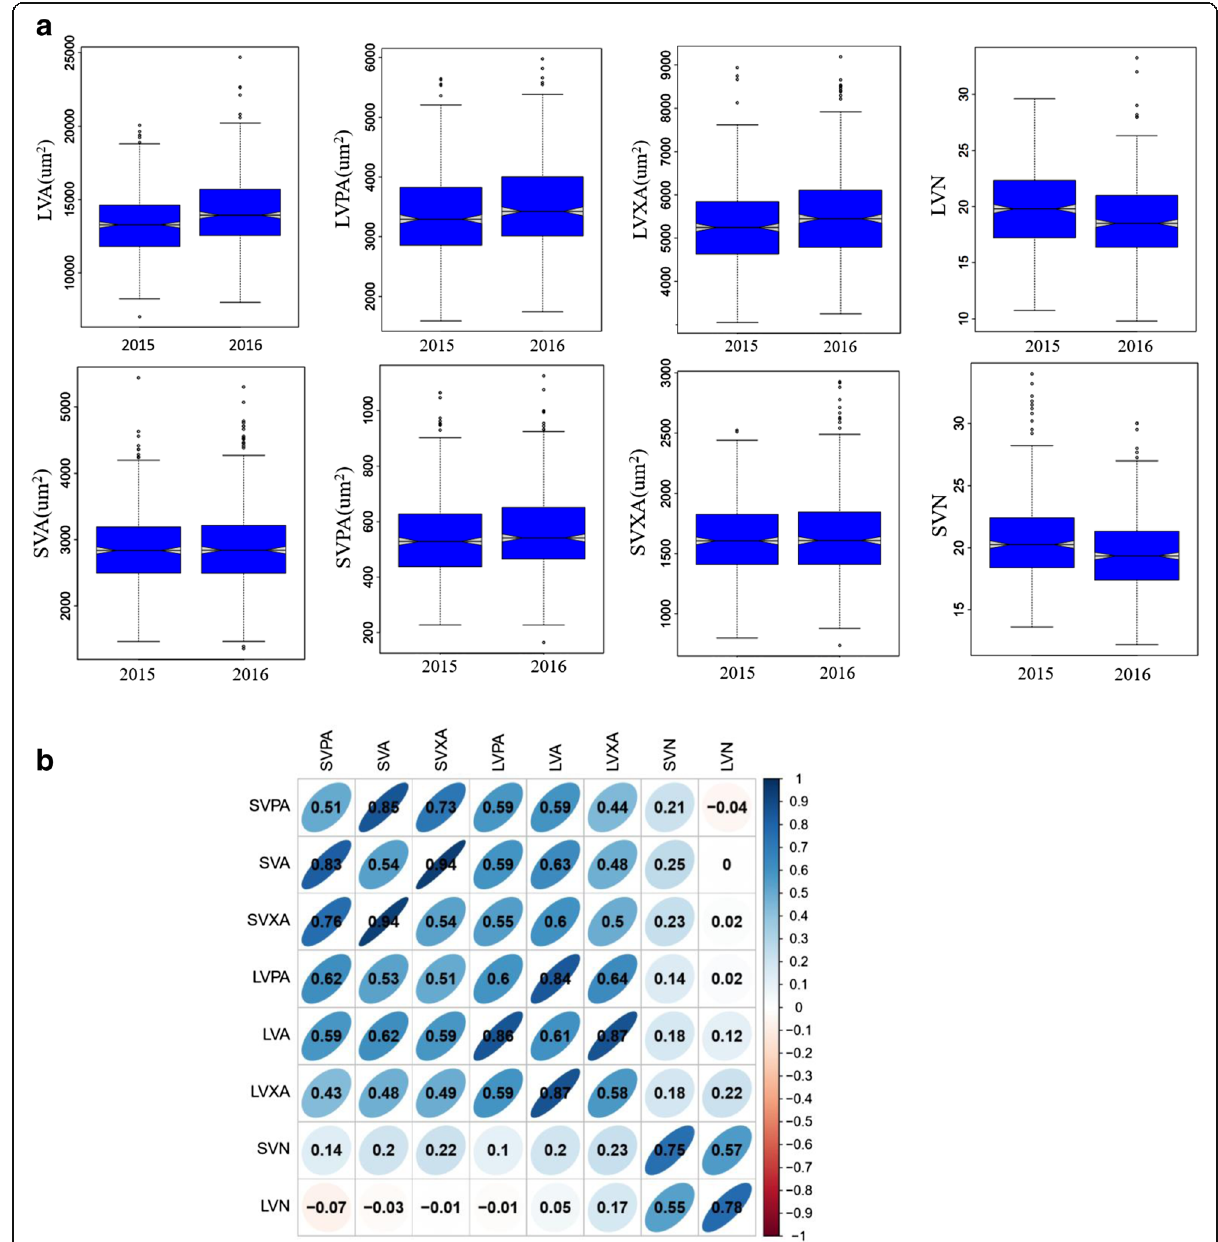
Fig. 1 a Box plots of eight rice vascular bundle related traits; the number of large vascular bundle (LVN), the area of large vascular bundle (LVA), the xylem area of large vascular bundle (LVXA), the phloem area of large vascular bundle (LVPA), the number of small vascular bundle (SVN), the area of small vascular bundle (SVA), the phloem area of small vascular bundle (SVPA) and the xylem area of small vascular bundle (SVXA). b Correlations between eight evaluated traits in 2015 (upper triangular) and 2016 (lower triangular). The values on principal diagonal indicate correlations between 2015 and 2016. The areas and colors of ellipses indicate the absolute value of corresponding r. Right and left oblique ellipses indicate positive and negative correlations,